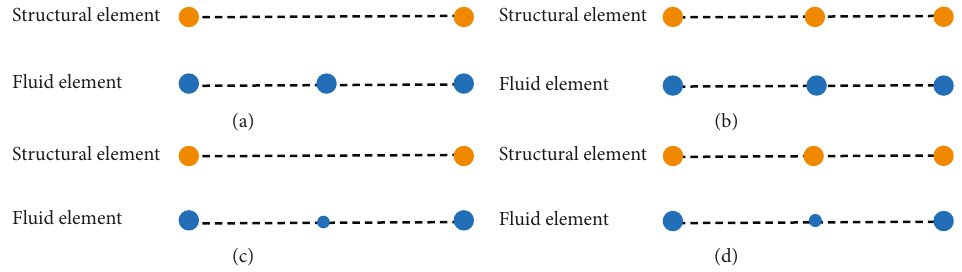
Figure 15: Mesh configuration for cases 1 to 4. (a) Case 1. (b) Case 2. (c) Case 3. (d) Case